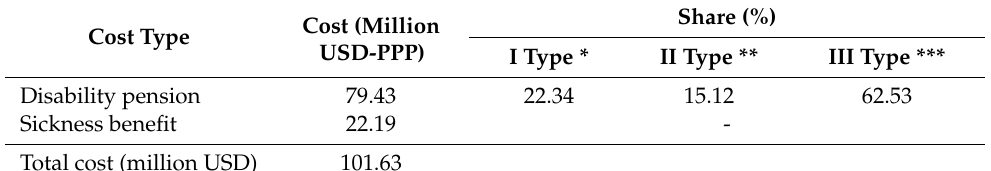
Table 6. Social care cost attributable to alcohol in million USD and percentage,